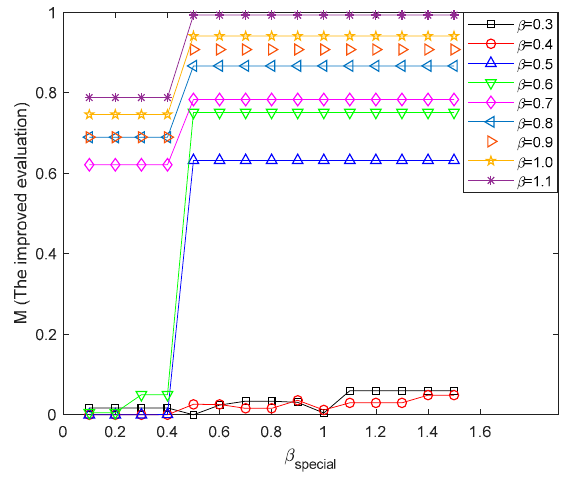
Figure 5. The influence of single-hop cluster head node capacity on G.